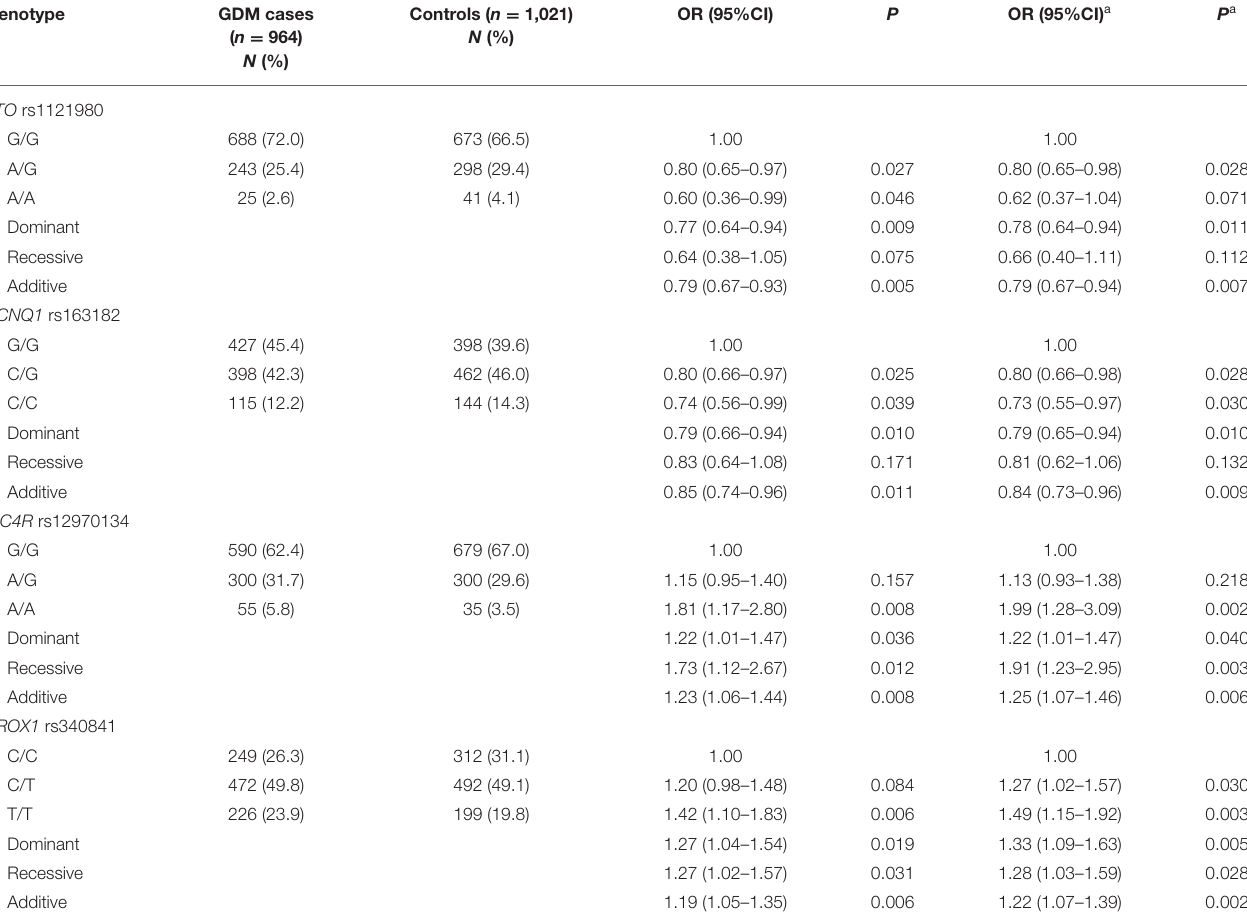
TABLE 3 | Association between four significant SNPs and GDM susceptibility.